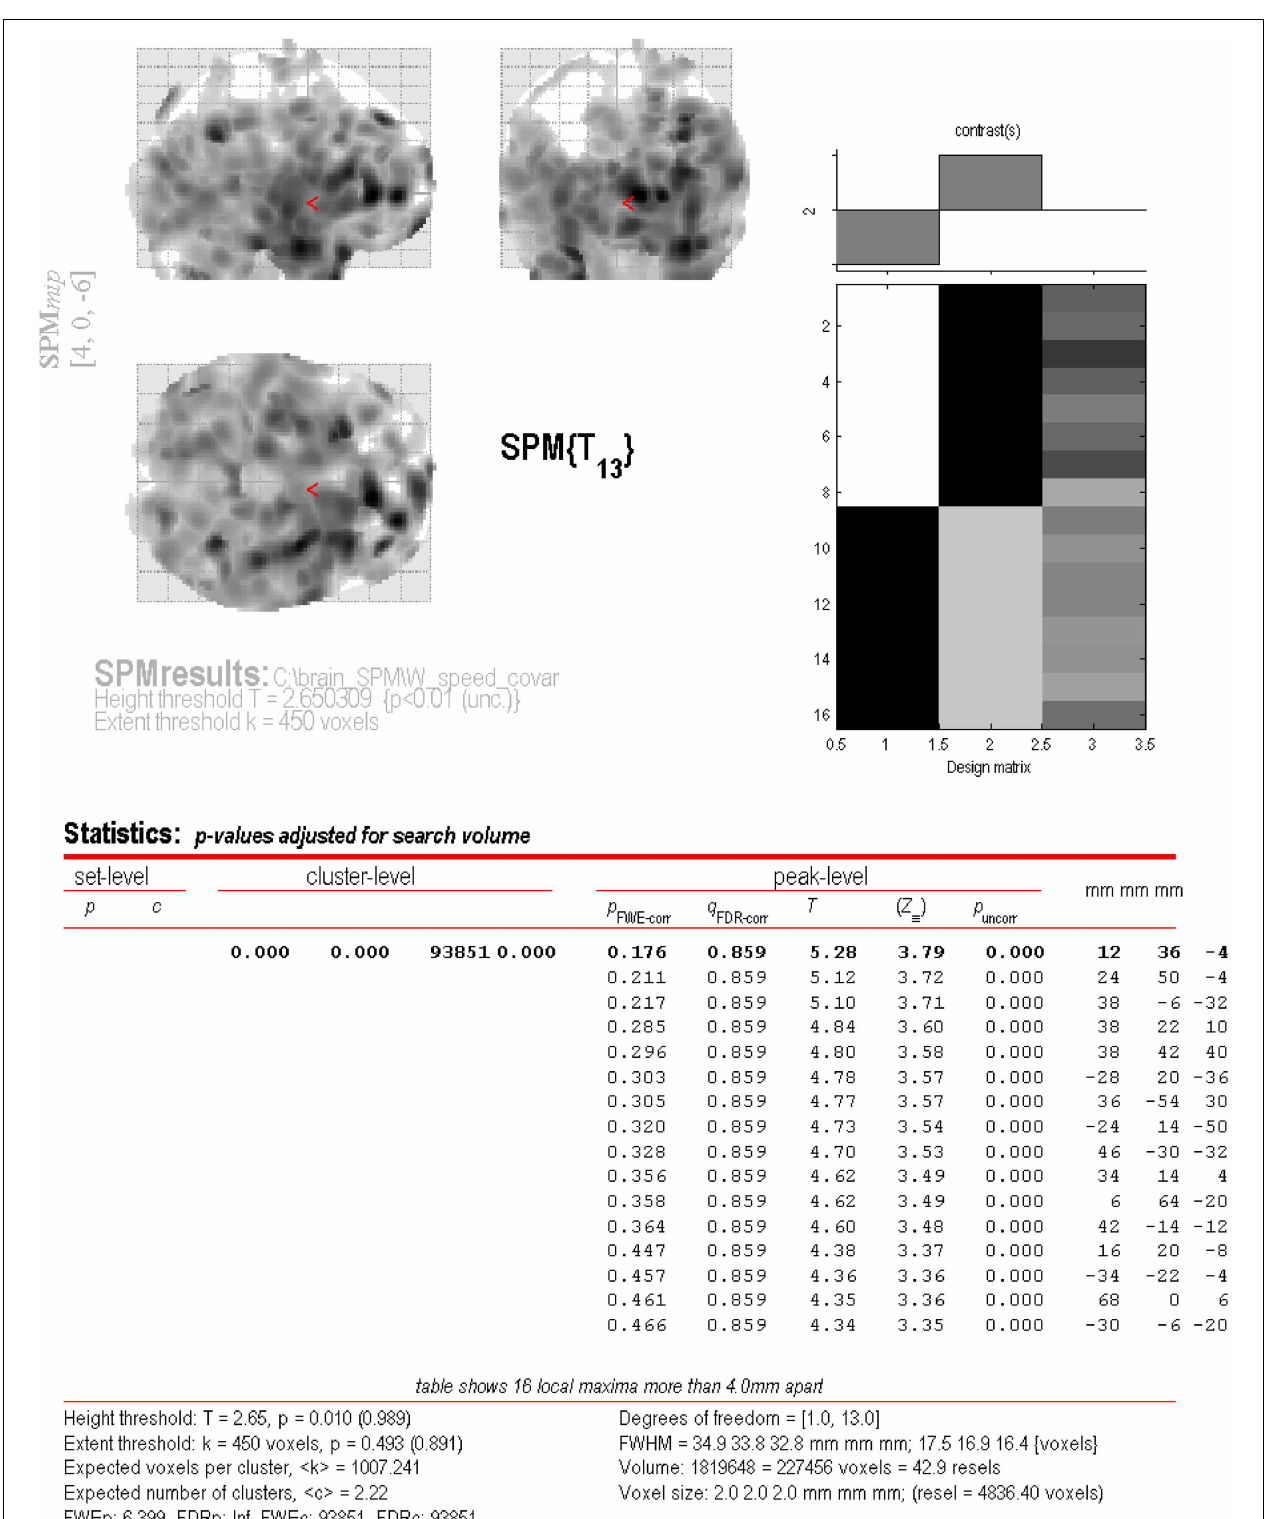
FIGURE 3 | SPM output of the areas of lower FDG uptake in patients with MS compared to controls .Within cluster information is displayed for the large cluster ( p FWE-corr < 0.001, q FDR-corr < 0.001, k e = 93851) identified during